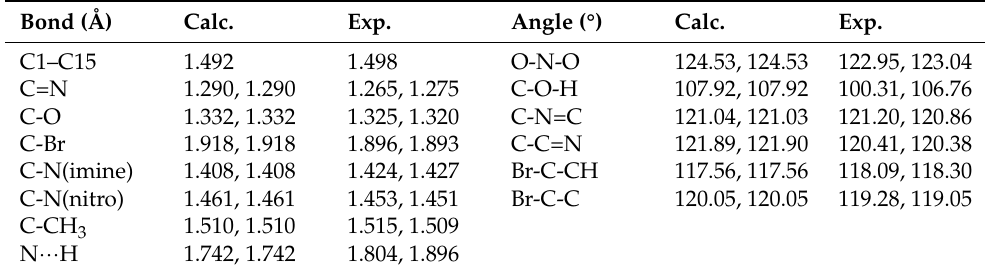
Table 1. Selected calculated and experimental bond lengths (Å) and angles ( ᵒ ) of ZH4 . Calc.